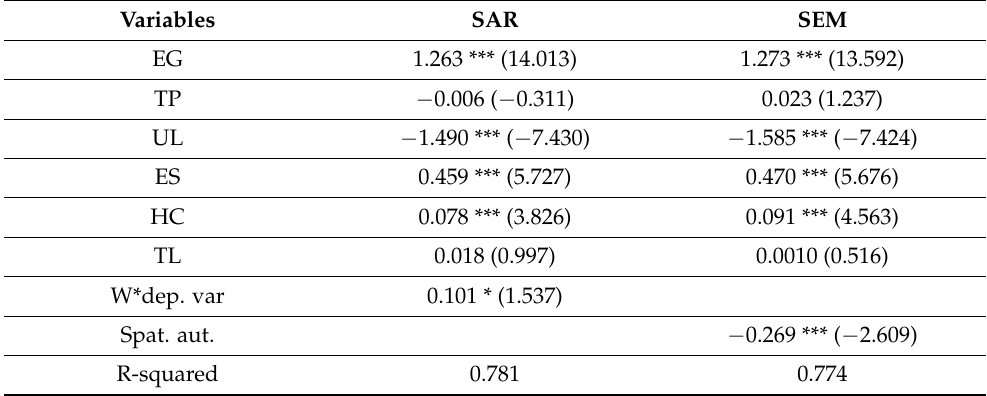
Table 5. The estimation and test results of spatial econometric model (time fixed effects